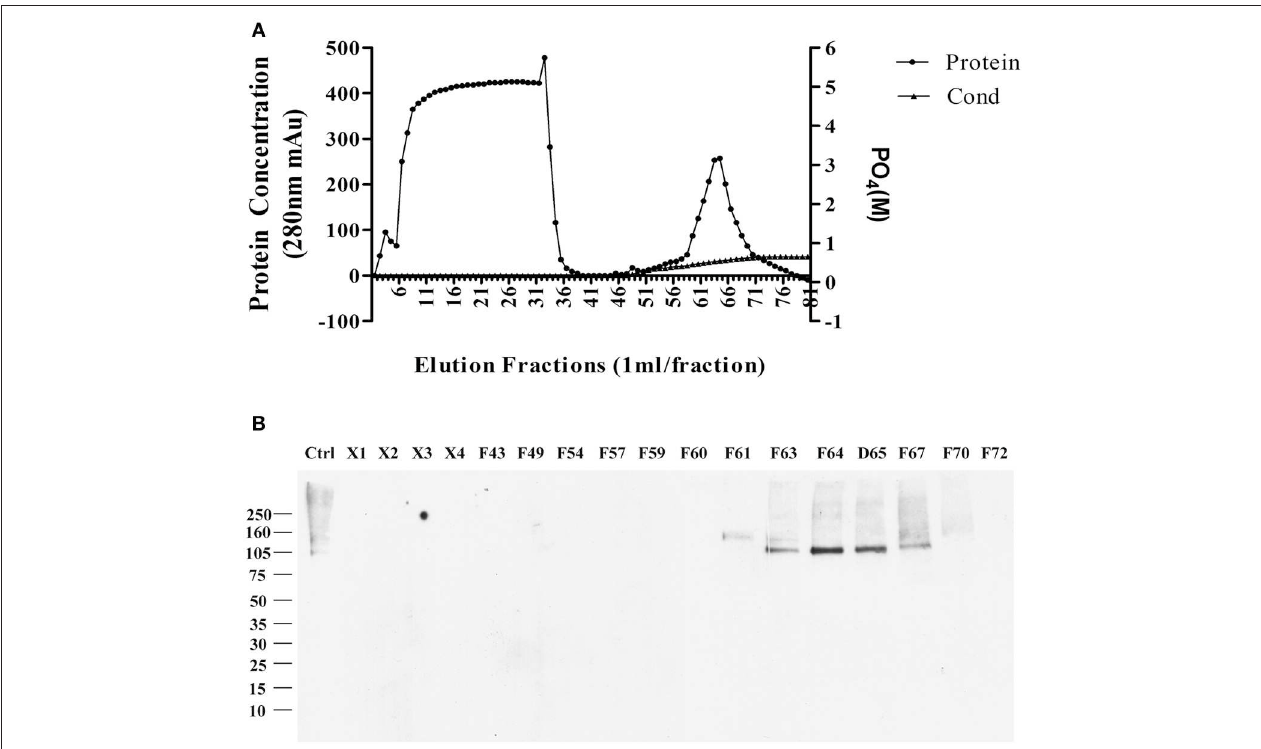
FIGURE 2 | Further enrichment of A β O binding protein p100 by CHT Cartridge HPLC. Fractions from the sucrose gradient containing the highest amount of p100 (fractions 14 and 15) were treated with SDS and 1h at 100,000g. Filtered supernatant were applied to CHT-column and fractions washed from the column by linear gradient sodium phosphate (10–700mM). (A) Relative protein abundance in fractions determined by absorbance and by conductance. (B) Selected fractions assayed for presence of endogenous A β O binding protein p100 by ligand blotting. Proteins in fractions X1–X4 did not bind to column and showed no A β O binding proteins. Fractions containing p100 (F63–65) were collected and dialyzed against 10mM Trit-HCl pH 7.4, and concentrated by ultrafiltration for